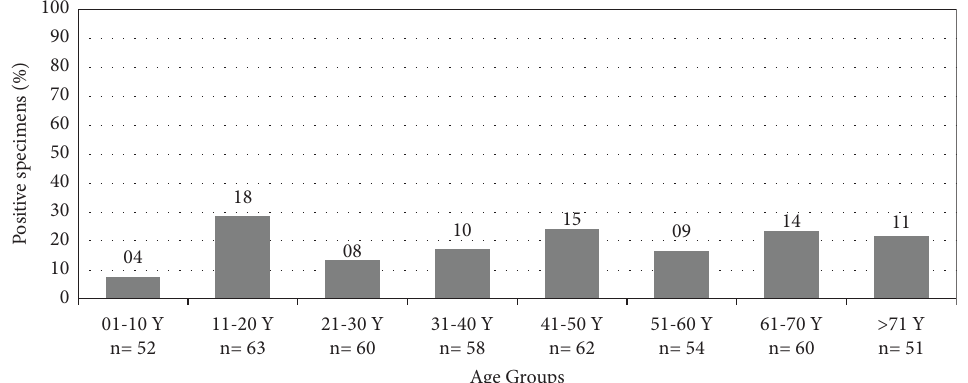
Figure 1: Rate of prevalence of H. pylori based on age groups with 10 years interval. Te number of positive specimens is shown above each